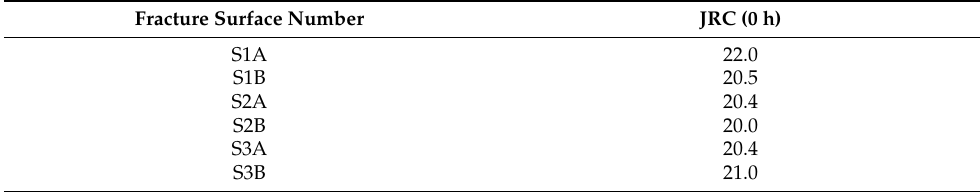
Table 1. Initial JRC values for sample surfaces.